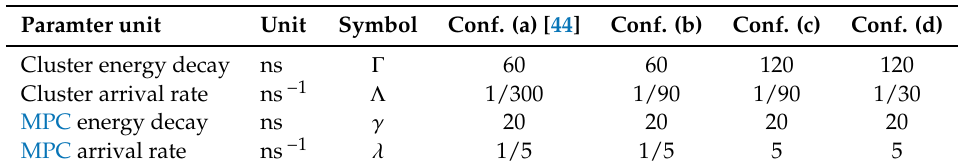
Table 1. Saleh–Valenzuela parameter combinations.